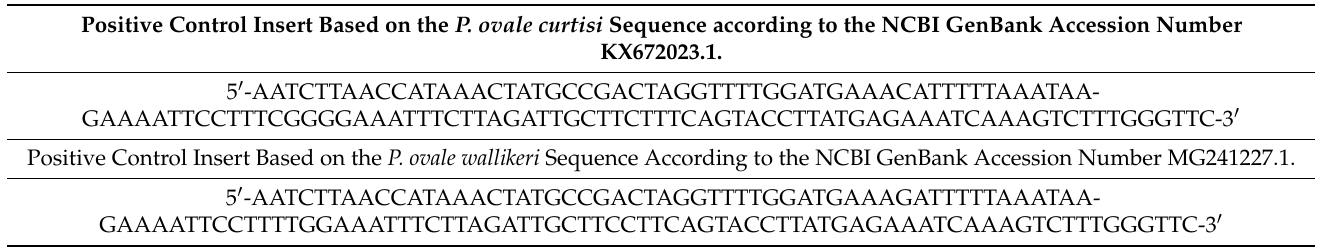
Table A2. Sequence inserts for the positive control plasmids of the differentiation PCR for the